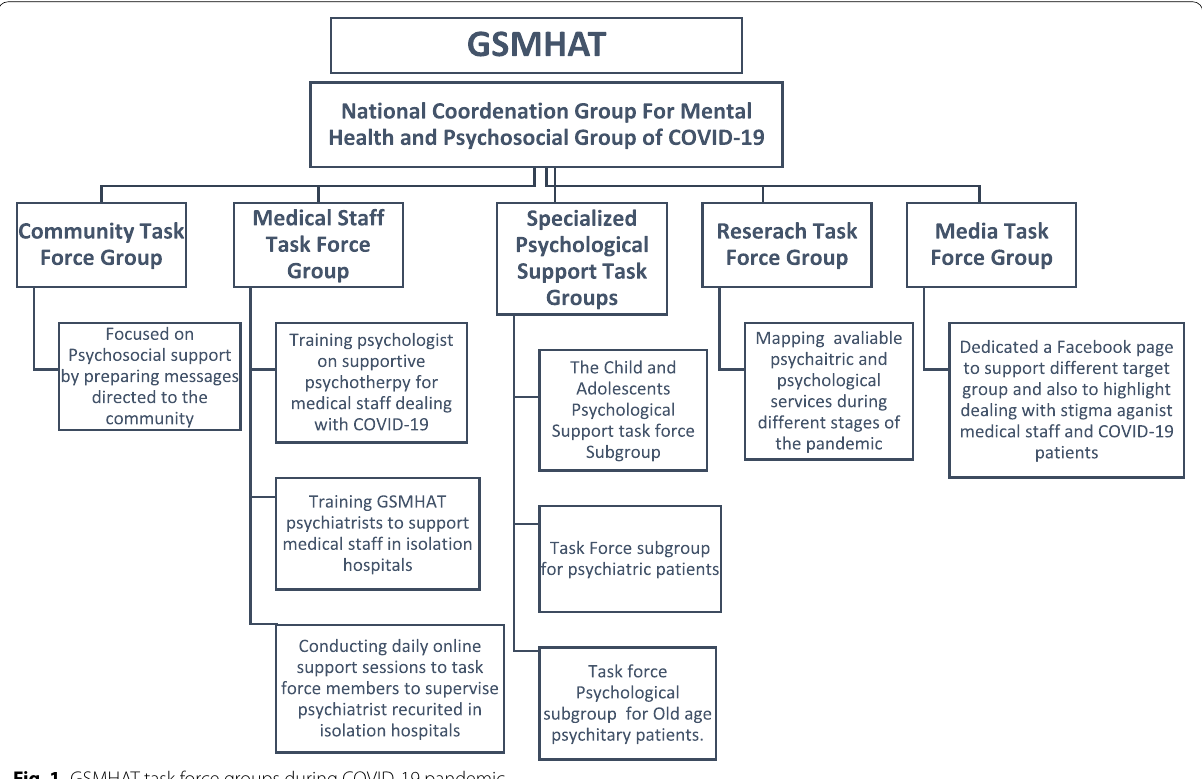
Fig. 1 GSMHAT task force groups during COVID‑19